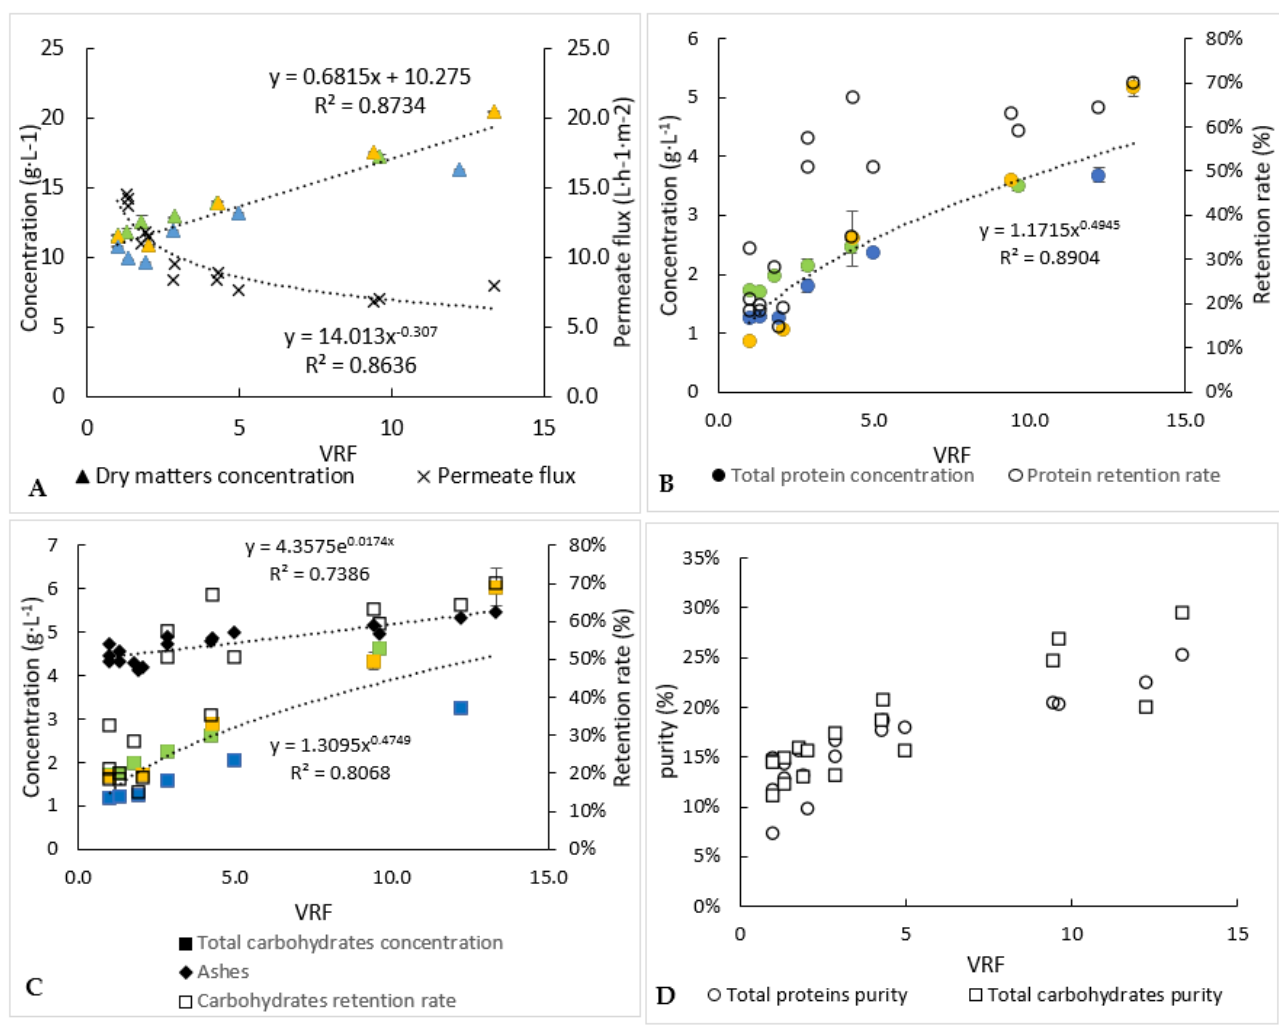
Figure 5. Biochemical follow-up of permeate and retentate during the 3 ultrafiltration experiments (each experiment is represented by one colour). ( A ) Dry matter concentration and permeate flux, ( B ) analysis of proteins, ( C ) analysis of carbohydrates and ( D ) index of purities. Error bars correspond to the standard variations between 3 replicates for proteins and 2 replicates for carbohydrates and dry matter. Table 2. Mass balance carried out following the ultrafiltration step.